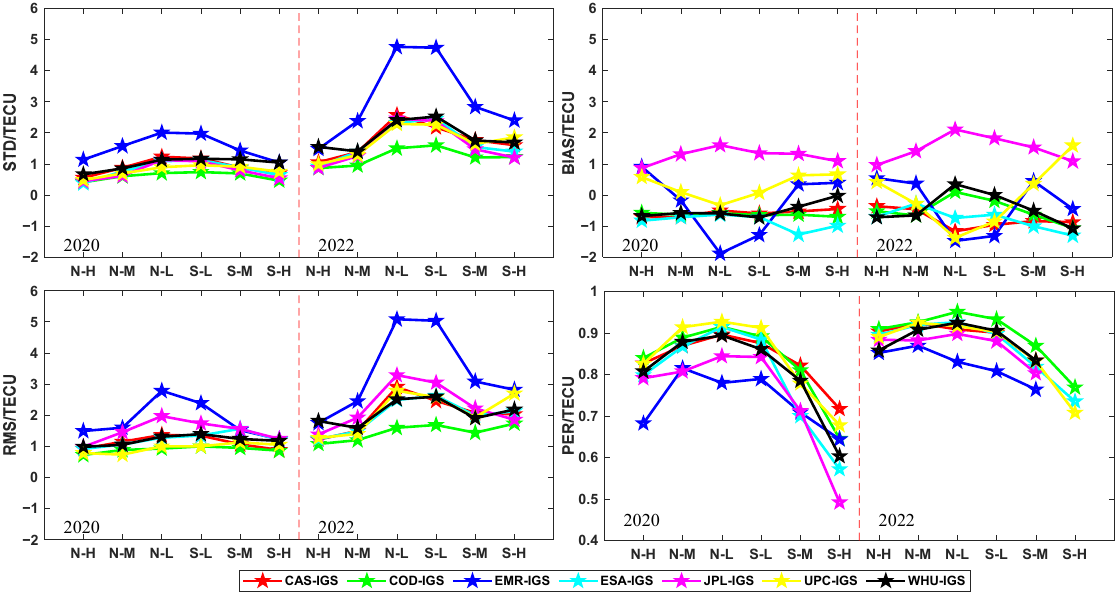
Figure 5. Model deviations of the GIMs compared to the IGS integrated GIM at different latitudinal bands.